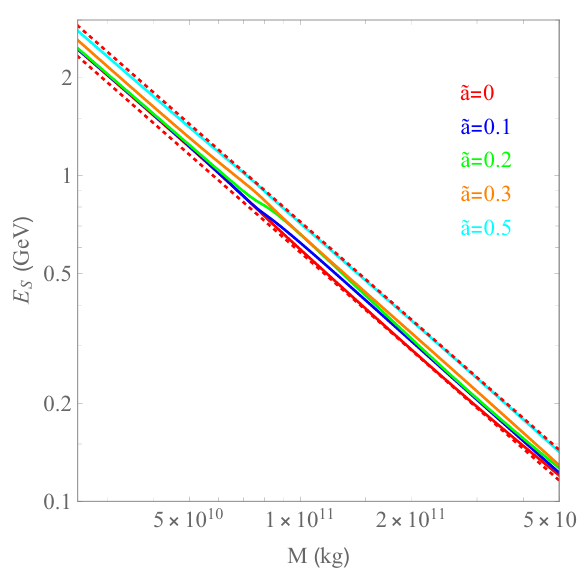
Figure 10 . “Shoulder” energy E S as a function of the PBH mass computed using BlackHawk and Hazma, for a ∗ = 0 , 0 . 1 , 0 . 2 , 0 . 3 , 0 . 5 (red, blue, green, orange and cyan,